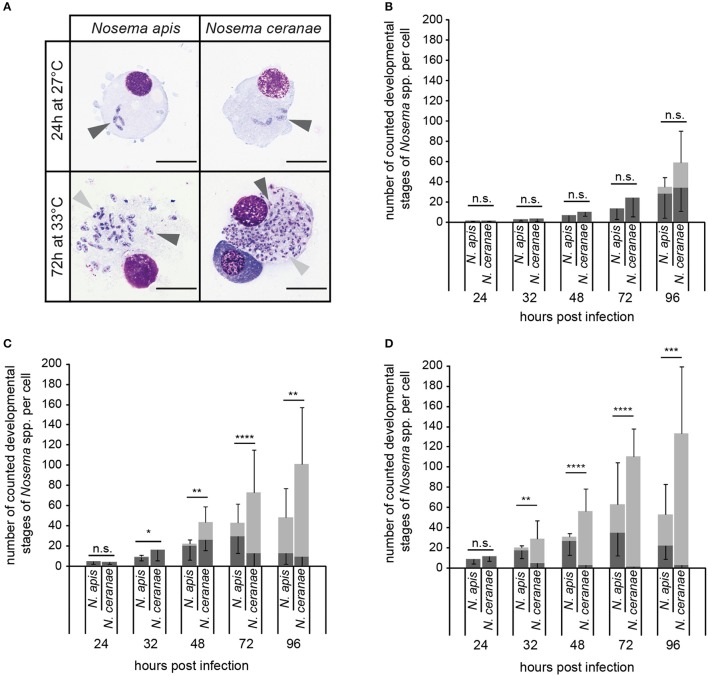
In vitro-infection of IPL-LD-65Y cells with N. apis- and N. ceranae-spores. Nosema spp. proliferation was determined by counting the number of developmental stages of merogony (A; meronts, dark gray arrow heads) and sporogony (A; sporonts and intracellular spores, light gray arrow heads) in infected cells (scale bars = 25 μm) incubated at 21°C (B), 27°C (C), and 33°C (D). Dark gray bars represent the number of meronts per cell (mean of 10 cells ± SD), light gray bars represent the number of sporonts/spores per cell (mean of 10 cells ± SD). Statistical analysis of the number of developmental stages was performed with student's t-tests for each time point and temperature. Statistical results given above the bars refer to the comparison of sporonts/spores produced by N. apis and N. ceranae (not significantly different: n.s., p ≥ 0.05; significantly different: *, 0.05 < p < 0.01; **, 0.01 < p < 0.001; ***, 0.001 > p ≥ 0.0001; ****
p < 0.0001).